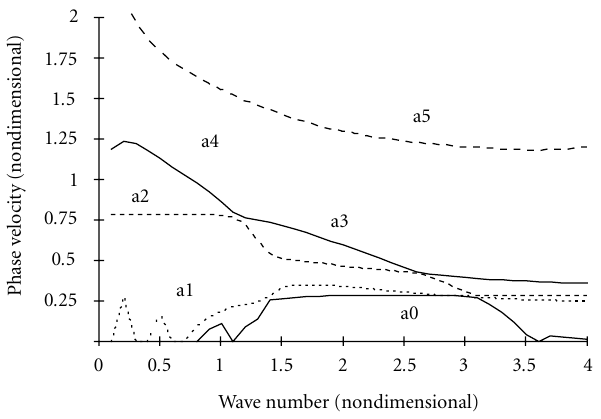
Figure 8.5. Dispersion of the first six flexural modes for τ 0 = 2 . 10 − 7 second and τ 1 = 2 . 10 − 6 second.